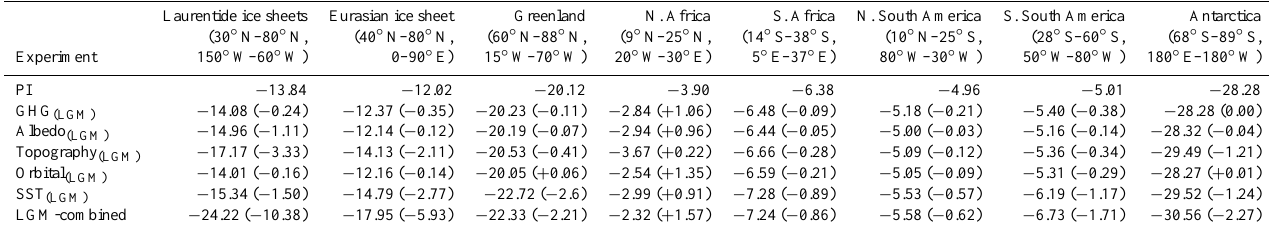
Table 6. Annual mean δ 18 O precip in ‰ as area averages for selected geographical regions (given in brackets, also a land mask dataset for LGM was used to select the regions in specific) in the different experiments. The difference from the control experiment is given in